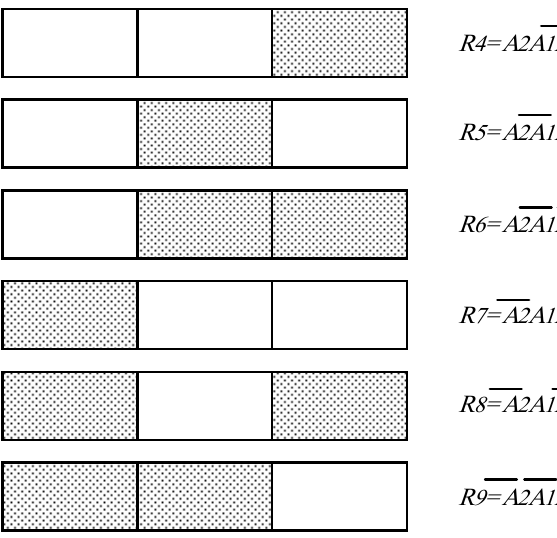
Figure 6. New reactants with k = 3.